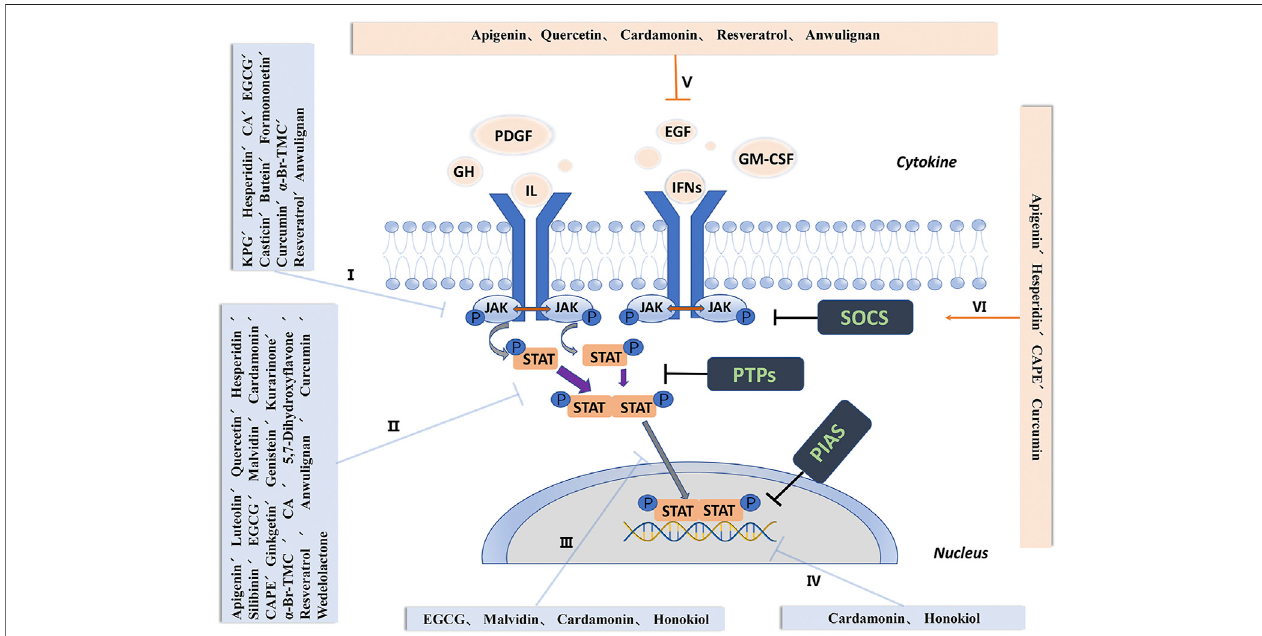
FIGURE 1 | Activation and negative regulation of the JAK-STAT signaling pathway. I, Inhibit activation and phosphorylation of JAK. II, Inhibit the activation, phosphorylation and formation of dimers of STAT. III, Interfere with the transfer of STAT to the nucleus. IV, Interfere with the binding of STAT and DNA and regulate the expression ofSTATtarget genes.V,Up-regulate thesecretionand expression ofnegative feedbacksignalSOCS.VI,Inhibitthesecretion ofinterleukin,interferon, tumor necrosis factor and binding to receptors. Abbreviations: GH, growth hormone; PDGF, platelet-derived growth factor; EGF, epidermal growth factor; IFNs, interferons; IL, interleukins; GM-CSF, granulocyte-macrophage colony-stimulating factor; JAK, janus kinase; STAT, signal transducer and activator of transcription; SOCS, suppressor of cytokine signaling; PTPs, protein tyrosine phosphatases; PIAS, protein inhibitors of activated STATs.